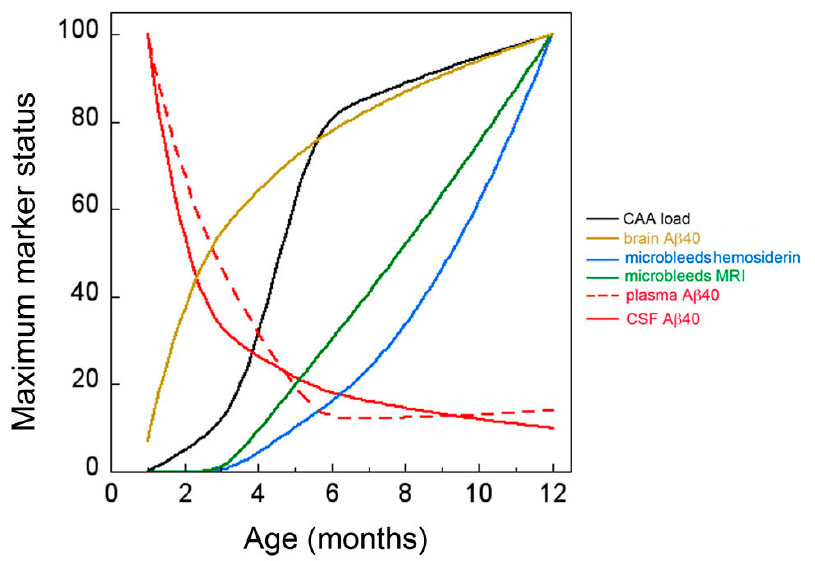
Figure 7. Trajectory of CSF and plasma A β 40 levels with the progression of CAA and associated microbleed pathology in rTg-DI rats. At one month of age, the levels of A β 40 in CSF and plasma are relatively high, whereas little A β 40 has accumulated in brain tissue, and CAA and microbleeds are not present. At three months of age, the levels of A β 40 in brain sharply increase and CAA begins to develop. At this same time, there is dramatic decrease in the levels of A β 40 in both CSF and plasma. At six months of age, the levels of A β 40 in brain and CAA continue to increase and microbleeds begin to emerge. The levels of A β 40 in both CSF and plasma continue to decline. Finally, at twelve months of age, there is a continued increase in brain A β 40, CAA load and expansion of cerebral microbleeds that is accompanied by further reduction in CSF A β 40.